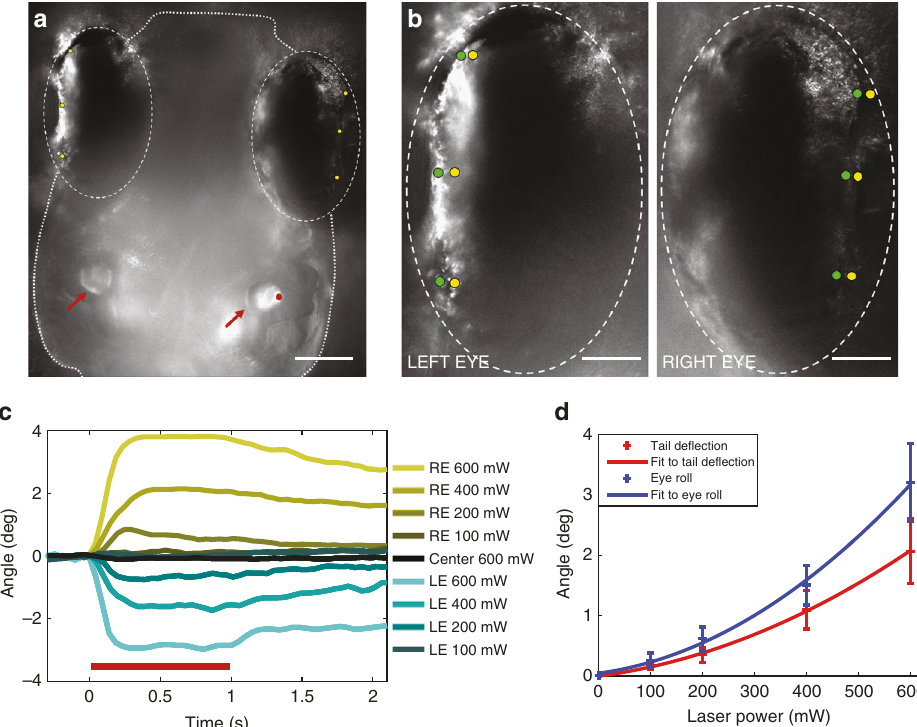
Fig. 4 Otolith trapping results in coordinated compensatory movements in eyes. a Dorsal view of a larva. Otoliths ( red arrows ), the position of the trap on the lateral edge of the right otolith ( red dot ), and pigment landmarks on the eyes ( yellow dots ) are indicated. Scale bar , 100 µ m. b Positions of pigment landmarks from a before ( yellow ) and during ( green ) a 600 mW trap. Scale bar , 50 µ m. c Rotation of the left ( LE , blue ) and right ( RE , yellow ) eyes vs. the midline at a range of trap powers (average of three trials from one larva). Responses for all larvae are shown in Supplementary Fig. 6. d Average across all fi sh ( n = 5) of the maximum de fl ection angle for the tail in red , and maximum eye roll in blue . Second order polynomial curves fi tting these data are shown, and SEM is indicated for each